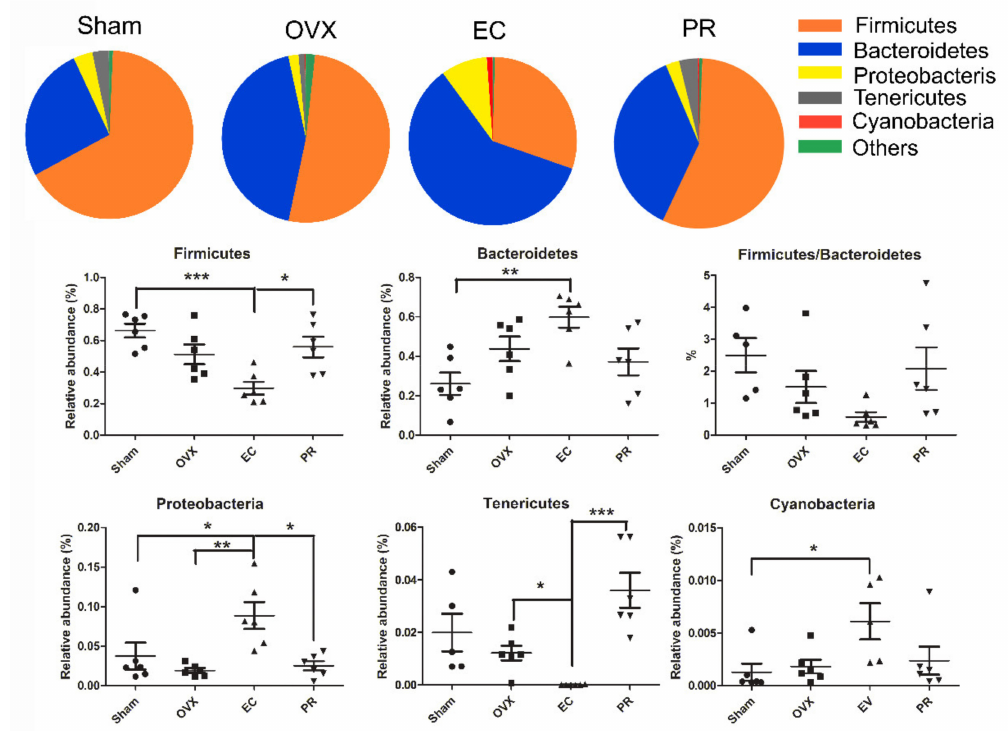
Figure 4. Community pie-plot analysis and microbiota alternation at Phylum level in Sham, OVX, EC and PR-treated OVX rats. n = 6 in each group. The dashes in the scalar diagram indicate means ± SEM. * p < 0.05, ** p < 0.01, *** p <